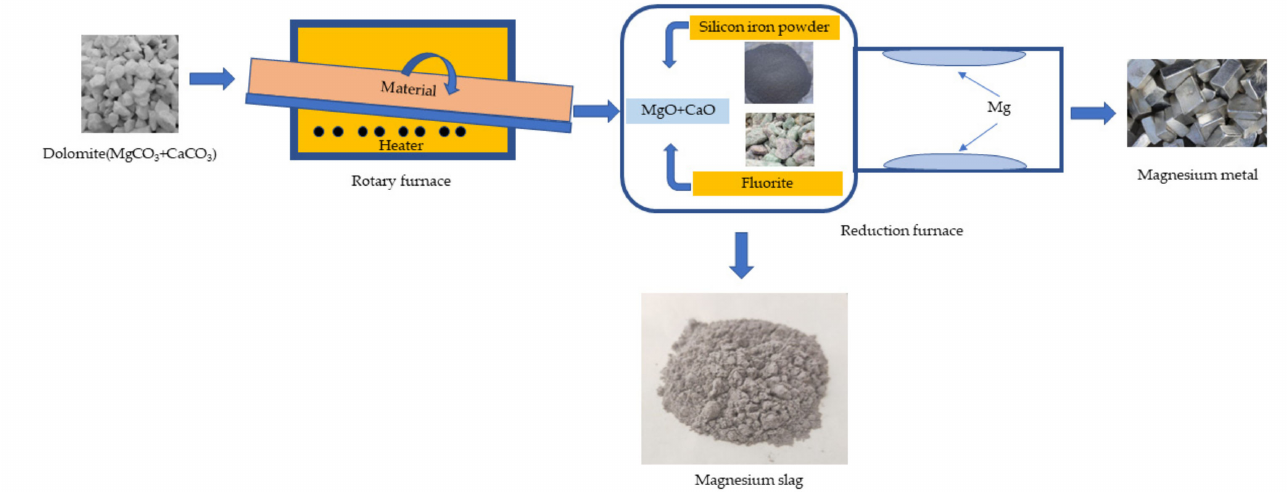
Figure 1. Flow chart of magnesium smelting by Pidgeon